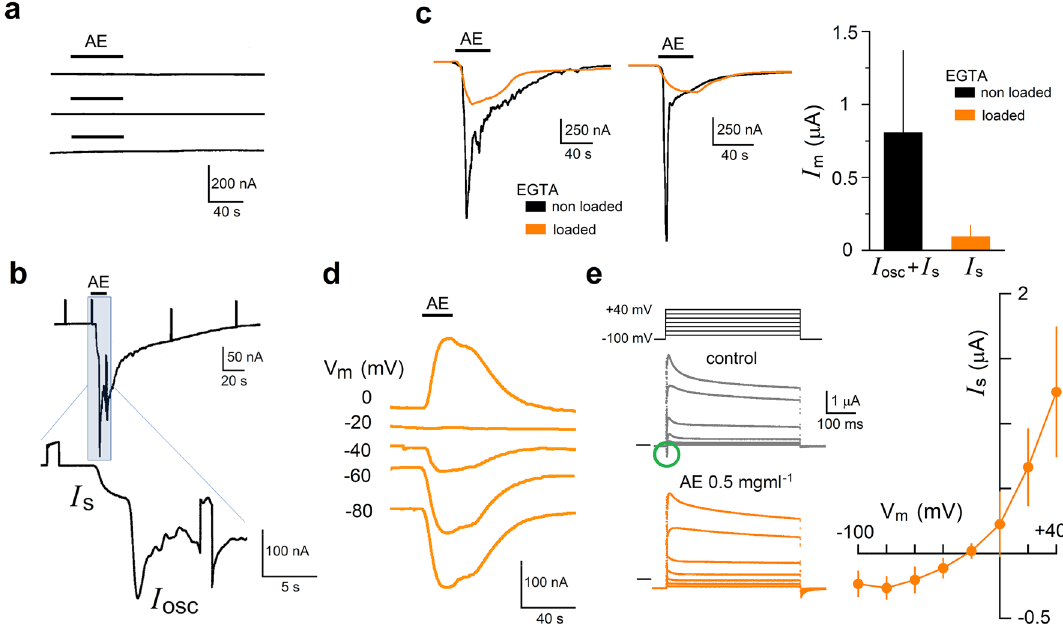
Figure 2. Bartholomea annulata venom produced three electrical responses in oocytes expressing membrane proteins from the rat brain. ( a ) Upper traces illustrate lack of current responses to application of anemone extract (AE, 0.1 mg ml −1 ) in three different control H 2 O-injected oocytes (3 frogs) under voltage-clamp held at − 60 mV, while in ( b ) traces show the current response elicited by AE in a mRNA-injected oocyte (expressing responses to different neurotransmitters as showed in Supplementary Fig. S1). Increase of the trace time- resolution signal in the insert (blue box) discloses activation of two currents with distinct temporal course, an early and smooth inward current, denoted I s , and a late and oscillatory inward current, denoted I osc . In ( c ) traces show that I osc current observed in control response (black traces; EGTA non loaded oocytes) was eliminated in EGTA-loaded oocytes, while inward current EGTA-resistant corresponded with I s time-course (orange traces). Total current responses ( I m ) obtained in 40 control and EGTA-loaded oocytes (right graph) indicated that I s was of 93 ± 17.7 nA (mean ± S.D.). ( d ) I s was elicited by 0.5 mg ml −1 AE superfusion in mRNA-injected oocytes that were EGTA-loaded, and holding the membrane potential as indicated in each trace, it is shown that I s reverted close to − 20 mV, similar result was obtained in 2 more oocytes from different frog. ( e ) Traces illustrate a voltage- step protocol applied in EGTA-loaded oocytes (n = 4) held at − 100 mV in the absence of AE (control, gray traces) and during the application of the venom (0.5 mg ml −1 ; orange traces); the current–voltage